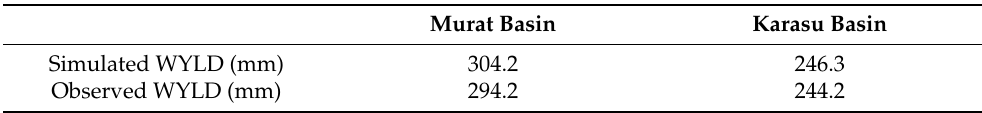
Figure 5. Hydrographs for ( a ) Murat and ( b ) Karasu basin in daily time-step. Table 8. Annual total water yield of Table 7. Performance statistics of SWAT modeling (daily time-step).